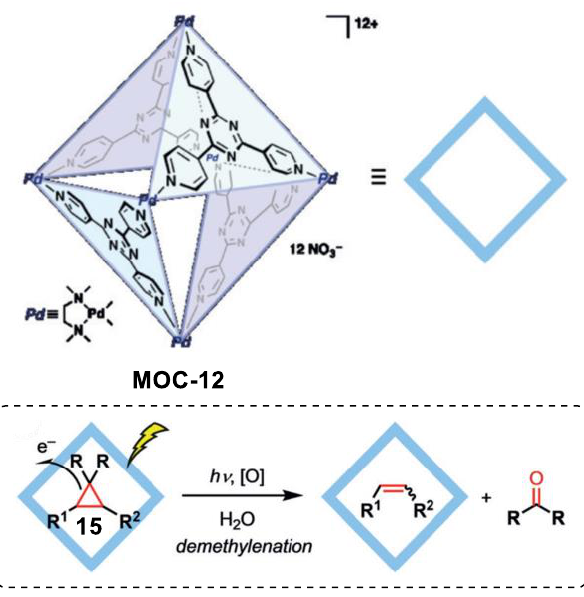
Figure 11. Demethylenation of cyclopropane catalyzed by MOC-12 [72]. Reaction additions: 15 (0.136 mmol), MOC-12 (100 mol%), UV light, H 2 O, r.t. Reprinted/adapted with permission from Ref. [72]. Copyright 2019 Wiley VCH.